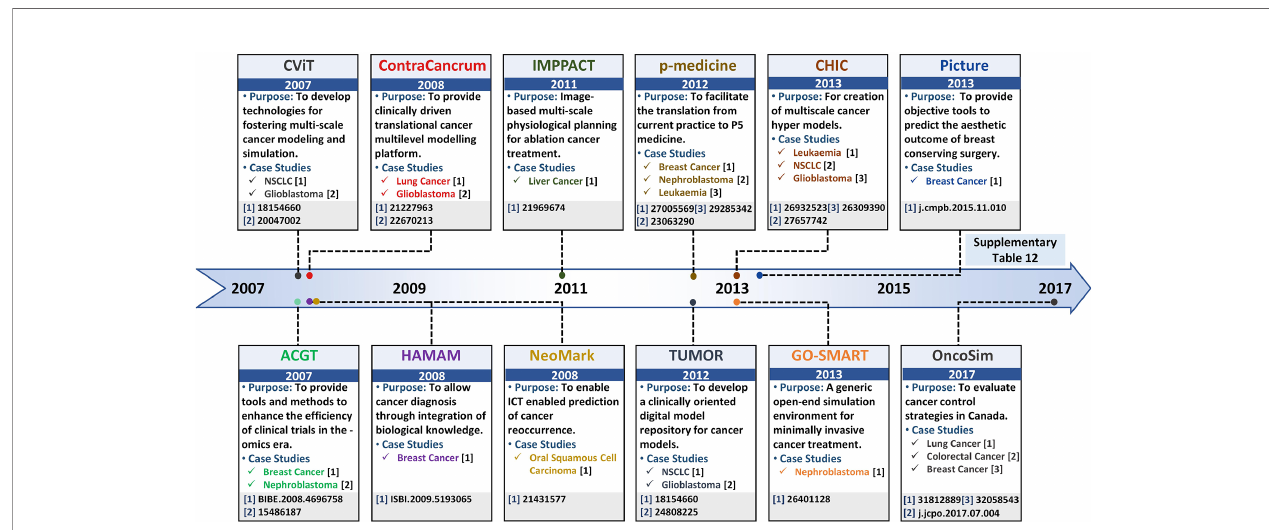
FIGURE 5 | Salient projects pipelining multi-scale panomics data into clinical settings – a timeline. Timeline highlighting salient project platforms for developing realistic and clinically-driven multi-scale cancer models, along with their associated leading case studies.